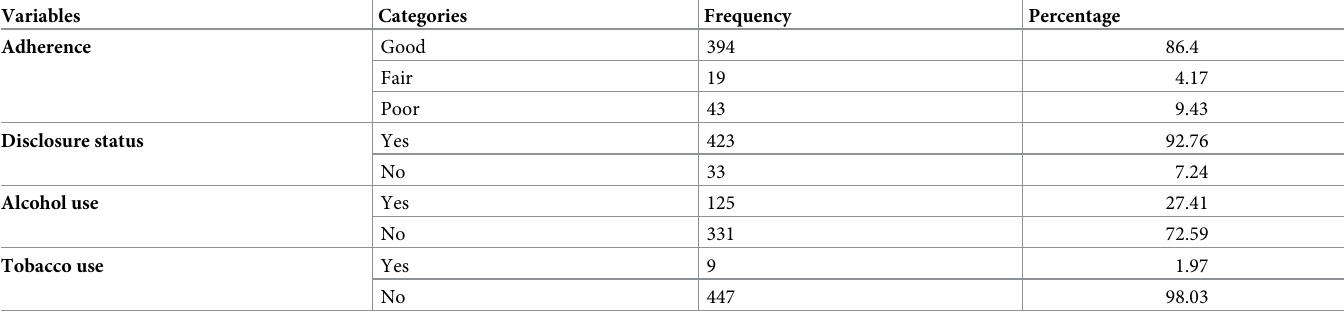
Table 2. Behavioral characteristics of HIV positive adults on HAART at Arba Minch town public health facilities, from January 2013 to December 2018 (N = 456).